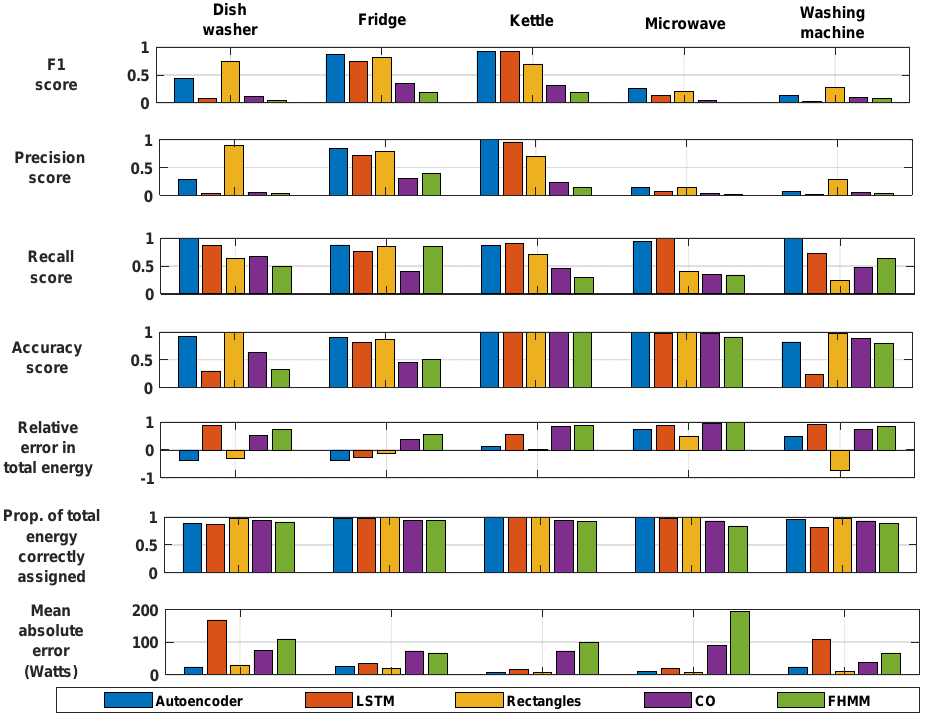
Figure 8. Energy disaggregation performance analysis for home unseen during training.